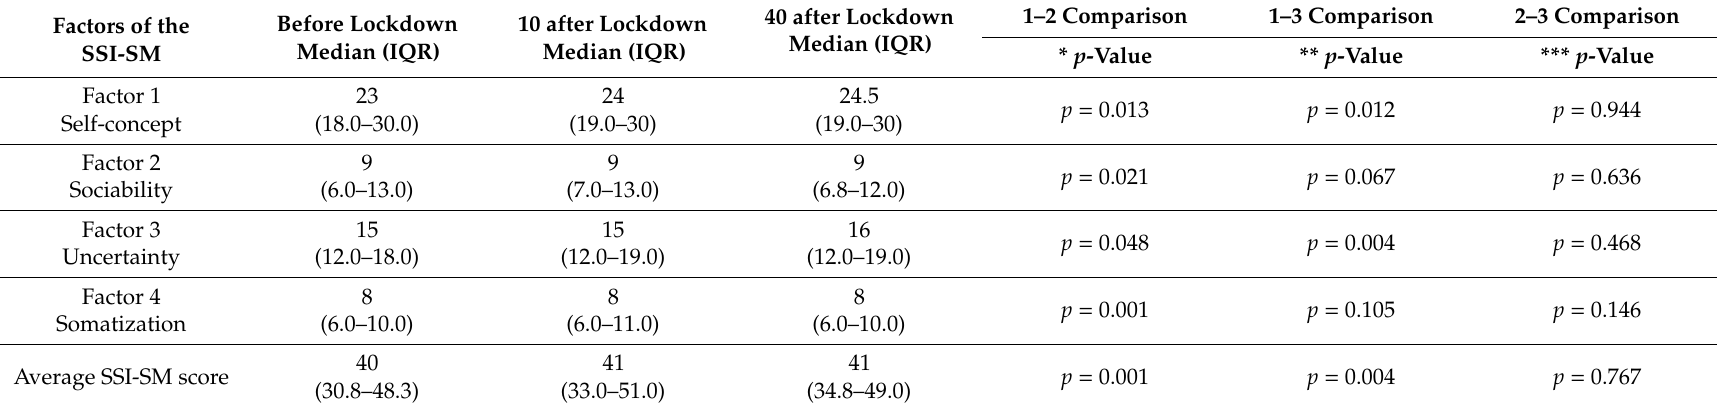
* For ‘before lockdown’ vs. ‘10 days after lockdown’ comparison. ** For ‘before lockdown’ vs. ‘40 days after lockdown’ comparison. *** For ‘10 days after lockdown’ vs. ‘40 days after lockdown’ comparison. SSI-SM = Student Stress Inventory-Stress